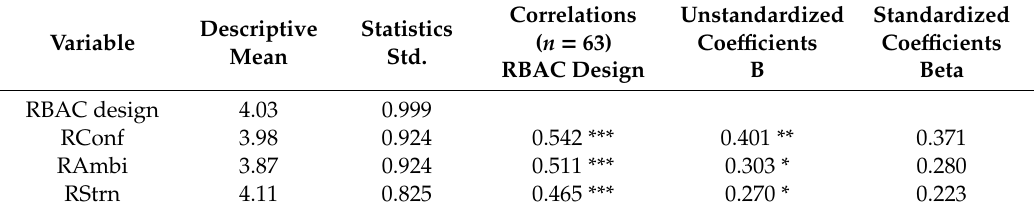
Table 6. Means, standard deviations, correlations, and coe ffi